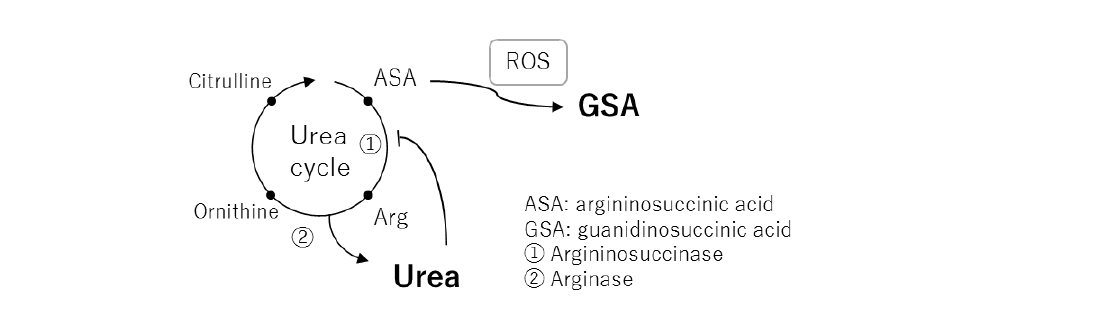
7 of 13 Figure 5. Scatter plot of five pairs of diagnostic blood tests and plasma metabolites. Black circles indicate samples from males and red circles indicate samples from females. ( a ) Blood urea nitrogen (BUN) test and urea, ( b ) uric acid (UA) test and uric acid, ( c ) creatinine (CRE) test and creatinine, ( d ) BUN test and guanidinosuccinic acid, and ( e ) gamma-glutamyl transpeptidase (γ -GT) test and cysteine glutathione disulfide. In the current study, we showed for the first time that GSA was correlated with BUN in normal healthy subjects (Figure 5d). In 1977, GSA was detected in blood and urine sam- ples from uremic patients and correlated with BUN [19]. This correlation is normally ex- plained by formation of GSA through the guanidine cycle from excess urea [20]. However, it is apparent that GSA is also produced by aberrant cleavage of argininosuccinic acid, an intermediate of the urea cycle, by reactive oxygen species such as hydroxy radicals [21,22]. The association of GSA with BUN is reasonable because their generation may commonly depend on the flux of the urea cycle and urea inhibition of argininosuccinase (Figure 6) [23]. Aoyagi et al. demonstrated that urea strongly increased the generation of GSA in rat primary hepatocytes and that norvaline, an inhibitor of the urea cycle, markedly de-